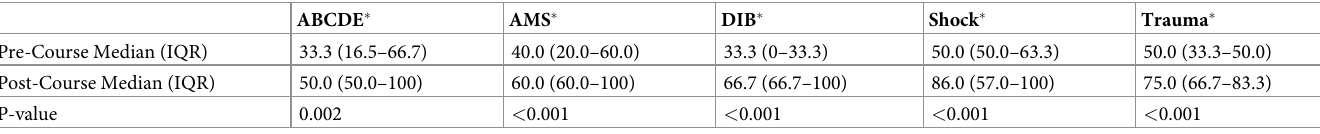
Table 3. Pre- and post-course test scores total, by question